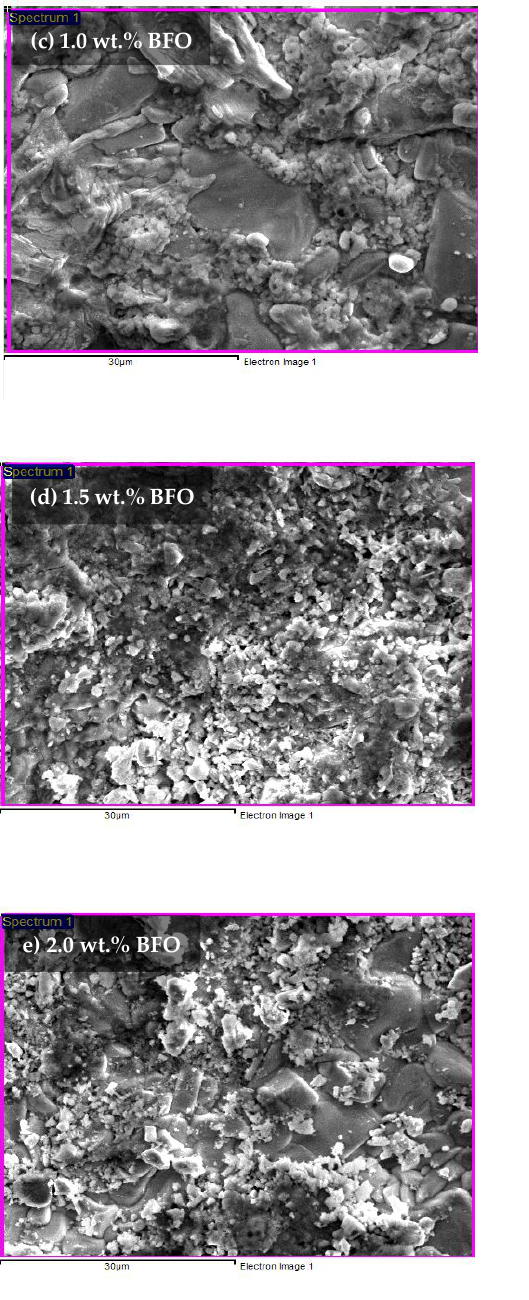
Figure 8. The EDX spectra for the Y-123 with different weight percentages of BiFeO 3 : ( a ) 0.0 wt.%,